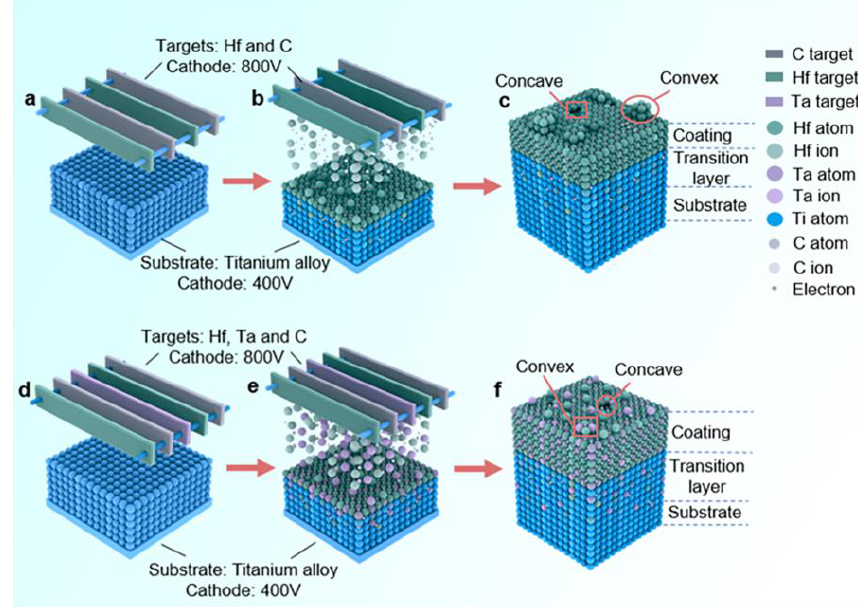
Figure 9. Growth process of ( a – c ) HfC coatings and ( d – f ) HfTaC 2 coatings . Molecules will be deposited on the surface of the sample to form a coating, while atoms tend to diffuse internally. Hf atoms and Ta atoms diffuse into the crystal by vacancy concentration, which will replace Ti atoms and form substitutional solid solution. C atoms diffuse into the crystal by an interstitial diffusion mechanism, which will form an intersti- tial solid solution. However, on the one hand, there are face-centered cubic HfC deposited on the surface, on the other hand, under the action of the electric field, wave after wave of atoms and molecules move to the sample surface, although some atoms have enough time to diffuse internally, while the next wave of atoms have no adequate time to diffuse inter- nally and deposit on the surface of the sample to form coatings, as shown in Figure 9b,e. The radius of carbon atom is far less than that of hafnium atom and tantalum atom, so when the coating is deposited on the surface, carbon atom tends to exist in the intersti- tial position, and form face-centered cubic structure (NaCl-type structure) of hafnium car- bide or solid solution. Atoms and molecules deposited on the surface of the sample form islands, so the coating nucleates and grows in island growth mode. Wave after wave of atoms deposit and form a layer structure, so it can be found that the growth mode of the coating is island- layered growth or Stranski-Krastonov growth mode [47,48]. After co-diffusion, the coat- ing structure formed is shown in Figure 9c,f, and there is a transition layer between the coating and the substrate. There are concave areas and convex areas on the surface of both HfC coating and HfTaC 2 coating, which is due to the island-layer growth mode of the coating, the islands are uneven in size, resulting in granular structures on the surface. The concave and convex in the HfTaC 2 coatings are not as evident as those in the HfC coatings, the reason for which is that besides Hf and C atoms, there are also Ta atoms, face-centered cubic hafnium carbide and tantalum carbide formed solid solution with single-phase char- acteristics. The radius of hafnium and tantalum atoms are different, lattice distortion oc- curred when solid solution was formed, which made the uniformity of island size en- hanced because of the stress suppression at the island edges [40,41]. Another reason for the small surface roughness value of the HfTaC 2 coatings is that the sputtering rate of tantalum is large, so the nucleation position on the surface of the matrix increases, forming a small size and a large number of islands. At the same time, when the coating is depos- ited, the melting point of the solid solution is higher than that of the hafnium carbide, and due to cell shrinkage, the surface diffusivity is reduced, the matrix temperature is fixed, and the materials with high melting point and low surface diffusivity form smaller grain